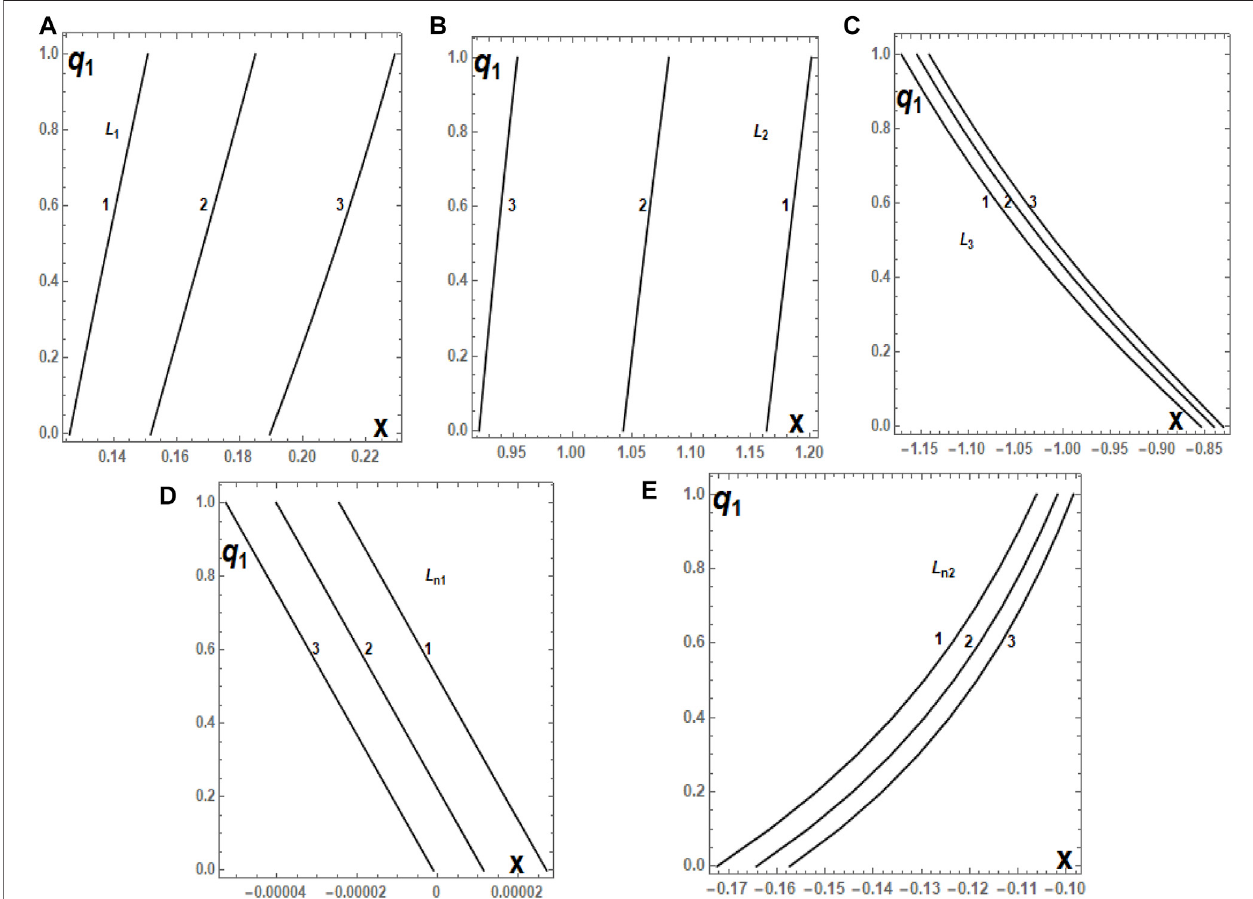
FIGURE7 |(A – E) Positions ofthe collinear equilibria L i , i = 1,2, 3, L nj , j = 1,2, of theHD11565system, asa function of q 1 ,which varies inthe interval (0, 1] for fi xed values of q 2 equal to 1 (1), 0.5 (2), and 0.1 (3), respectively. The disc, oblateness, and triaxiality parameters are kept as constants as given in Table 4 . The numbering of equilibrium points is according to the diagram shown in Figure 2